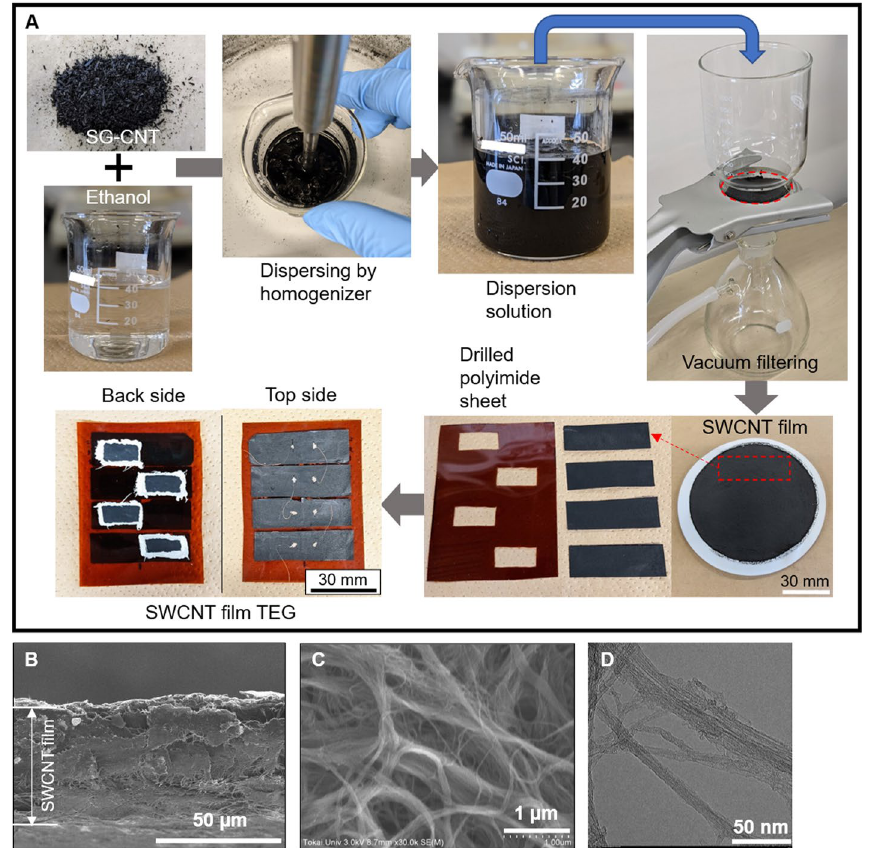
Figure 2. Fabrication and structural characterization of the water-floating SWCNT film TEGs. ( A ) Photographs showing the synthesis of SWCNT film TEGs. ( B ) SEM cross section of an SWCNT film. ( C ) SEM image of an SWCNT film surface. ( D ) TEM image of SWCNTs.